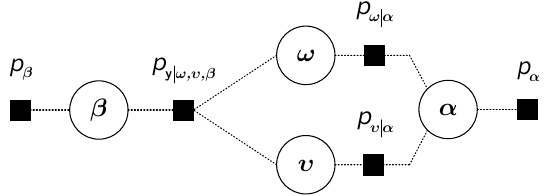
Figure 5. Factor graph representation of the joint PDF